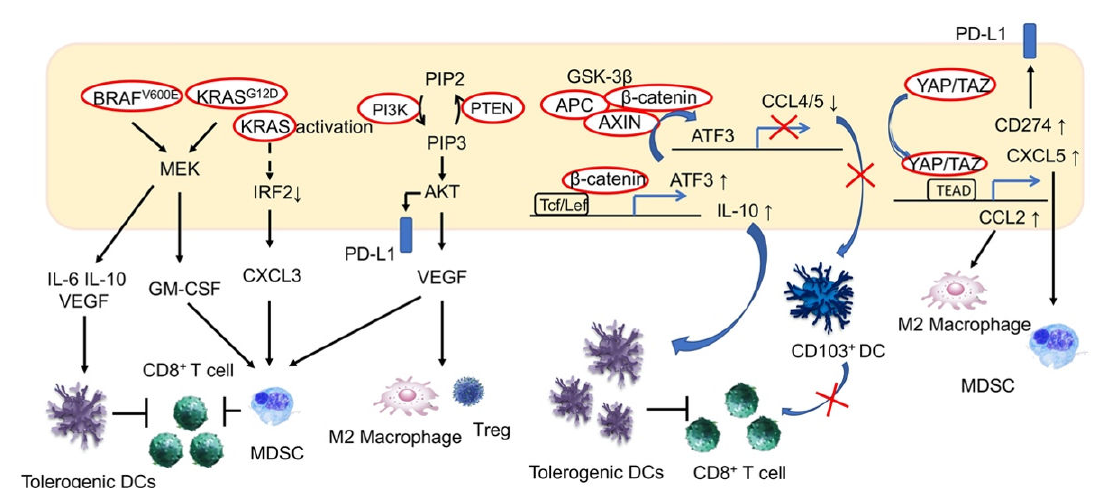
Figure 2. Effects of oncogenic signal activation on the tumor immune